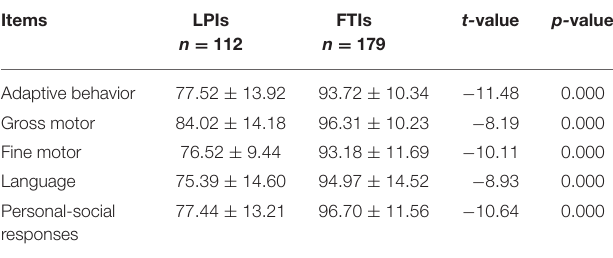
TABLE 4 | Comparison of GDDS scores between LPIs and FTIs ( x ±